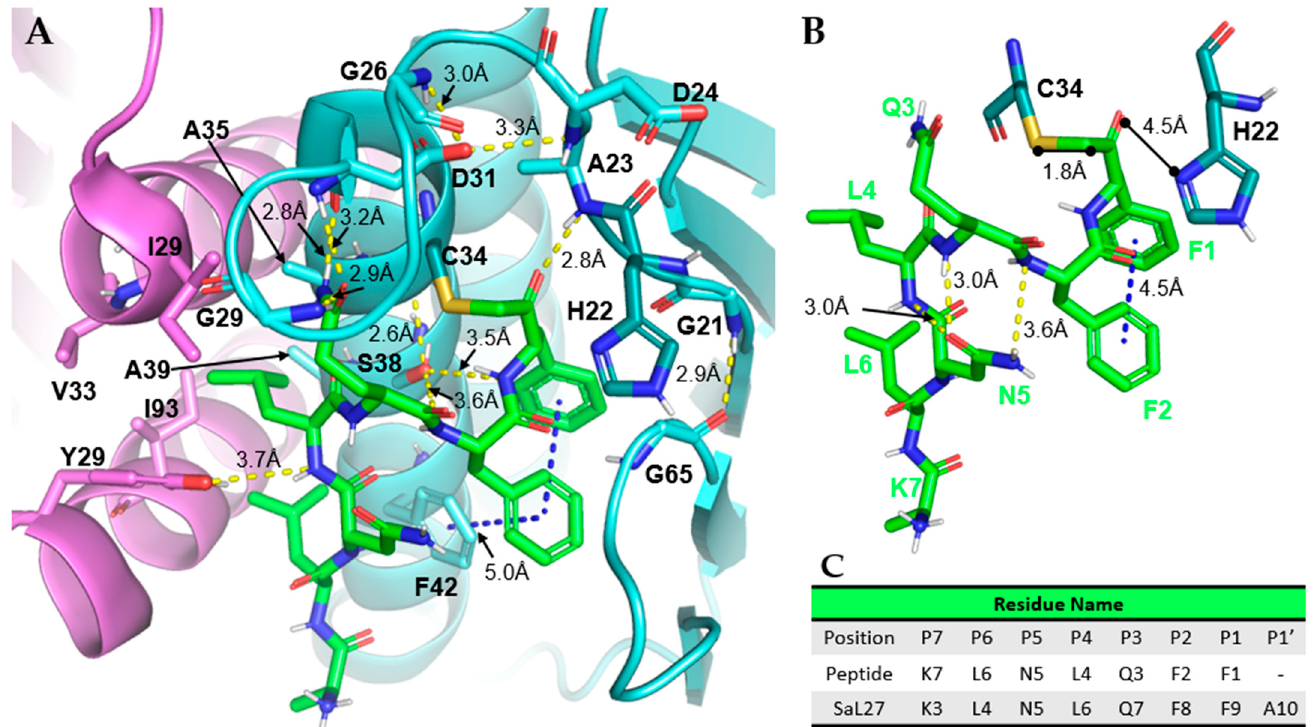
Figure 6. Interactions between acetyl-KLNLQFF-chloromethylketone (termed Ac-KLNLQFF-CH 2 - when covalently bound) and Sa Prp. ( A ). Intermolecular forces between peptide (green) and Prp (subunit A is cyan with His22 and Cys34 in teal, subunit D is violet). Noteworthy Prp residues are bolded. ( B ). Interactions between covalently bound peptide (green) and catalytic residues (teal). ( C ). Table with L27 cleavage sequence naming conventions. All images produced with PyMOL Molecular Graphics System, Version 2.0 Schrödinger, LLC. Dashed yellow lines indicate hydrogen bonds, blue dashed lines are π - π interactions.